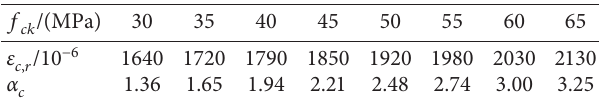
Table 6: Coefficients in the stress-strain relationship for